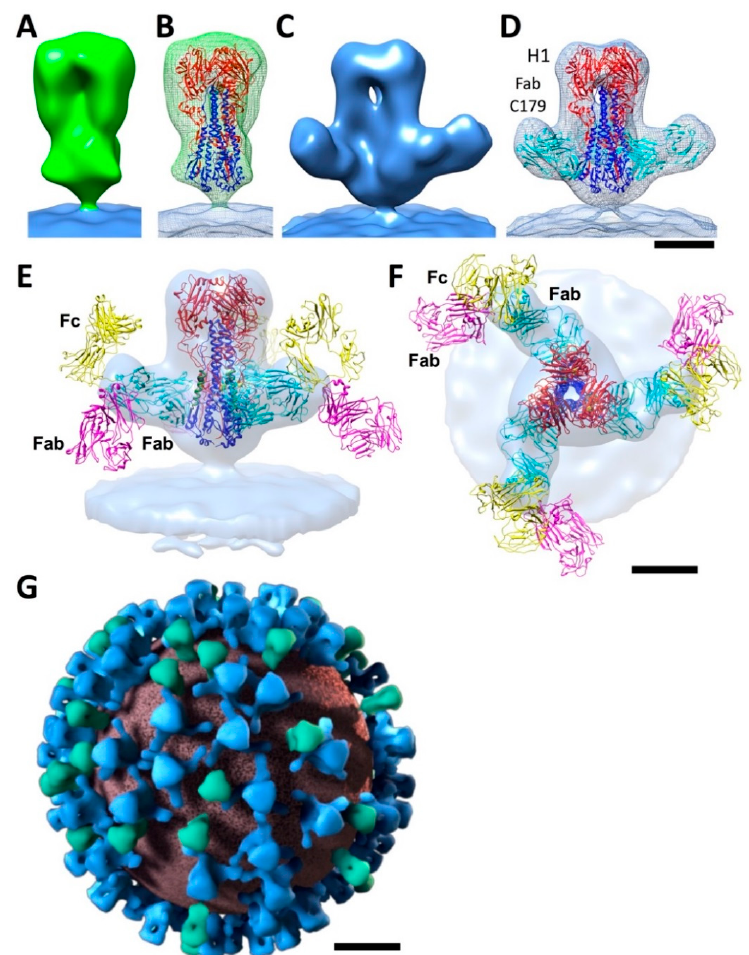
Figure 3. Three-dimensional structures of HA embedded in the viral membrane by cryo-electron tomography (cryo-ET). ( A ) side view of the 3D structure of H1 HA embedded in the viral membrane derived from cryo-electron tomography of 2009 H1N1 pandemic influenza virus. The 3D map is shown as a solid isosurface (green) with the membrane region colored blue; ( B ) docking of HA1 (red) and HA2 (blue) ectodomain coordinates (PDB 3LZG) into the density map of trimeric HA, shown as wire mesh; ( C ) side view of the density map of the complex formed by C179 antibody with trimeric HA. The HA-C179 map is represented as a solid isosurface (blue); ( D ) molecular model of the H1 HA-C179 complex by docking H1 HA (PDB 3LZG) and C179 Fab coordinates (PDB 4HLZ) into the HA-C179 map (wire-mesh); ( E , F ) top and side views, respectively, for a model of IgG molecules bound to C179 stem epitopes on viral HA. H1 coordinates (PDB 3LZG) were docked into the HA-C179 density map along with three surrogate IgG molecules (PDB 1IGY) based on Fab density protruding from the HA-C179 map. HA and Fabs are shown as ribbons, with HA1 in red, HA2 in blue, helix A of HA2 in green, the Fc region of the antibody in yellow. The non-bound Fab arm is magenta, and the Fab arm used to dock the IgG into the map in cyan. Scale bars, 5 nm; ( G ) 3D model of the distribution of unbound HA (green) and C179-bound HA (blue) spikes on a virus surface. Membrane is displayed as brick red. Scale bar, 20 nm. Virus is pandemic 2009 H1N1 influenza virus. Panels ( A – G ) were based on and adapted from Harris et al. [45]. Panels ( A – D ) used deposited 3D maps from the Electron Microscopy Data Bank (EMDB) (H1, EMD-5682; H1-C179, EMD-5684).